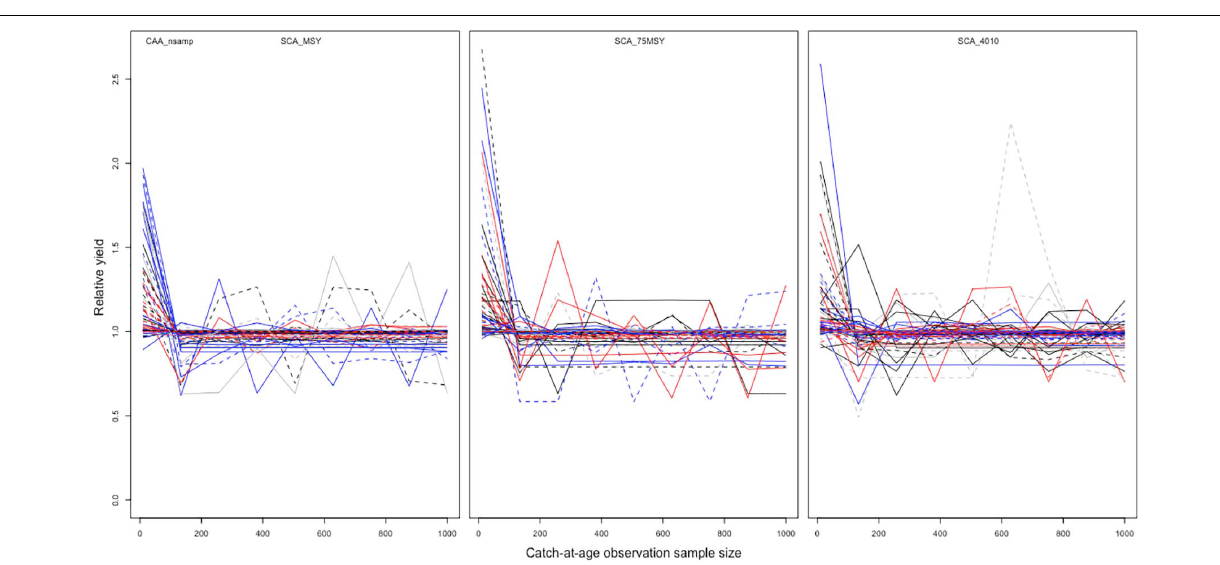
FIGURE 5 | Results of 128 simulations of the parameter CAA_nsamp with three